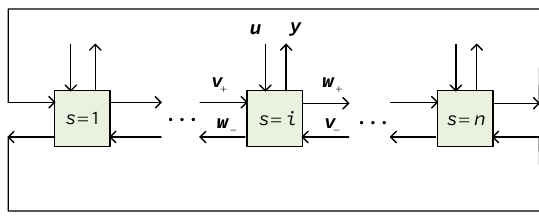
Figure 1. Spatially interconnected